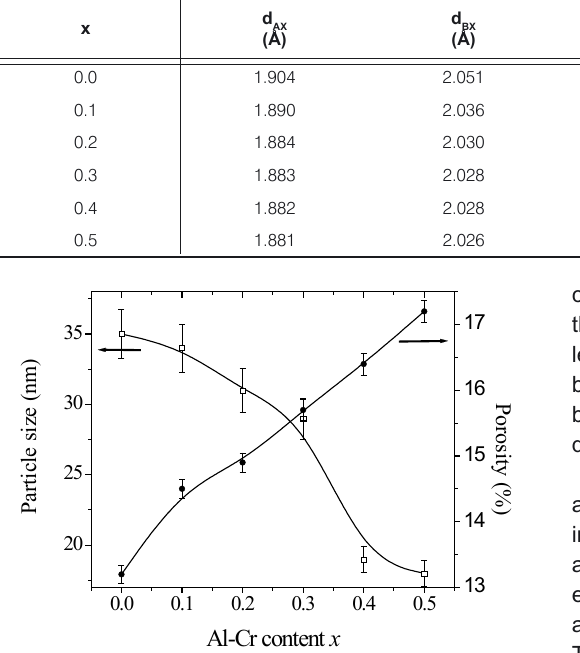
Figure 2. Variation of particle size and porosity with Al-Cr content x.